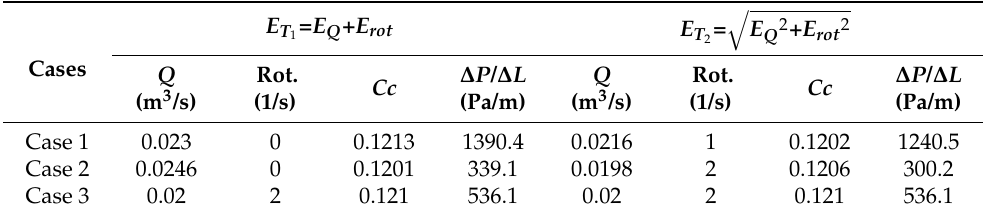
Table 8. Optimal flow rate and pipe rotation speeds when a 1 = 10,000 ( Cc =